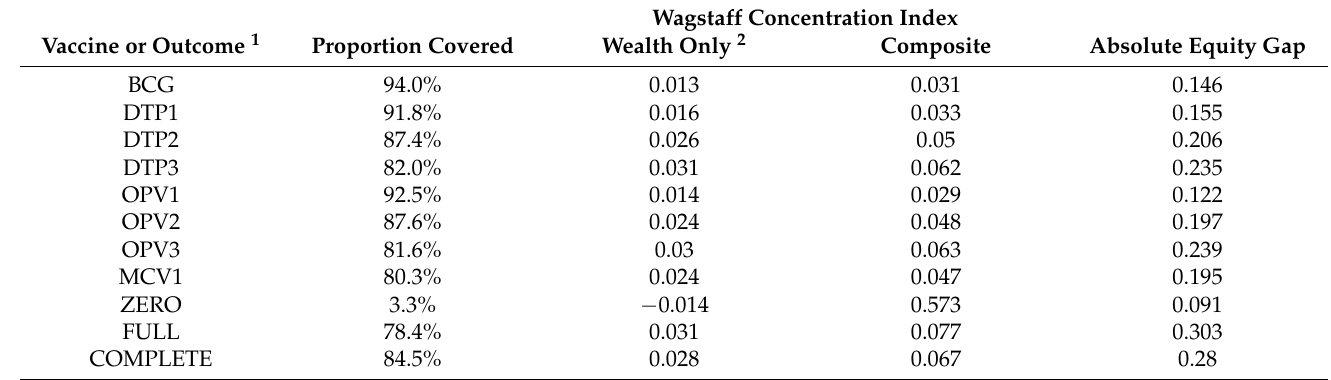
Table 1. National-level metrics for coverage/prevalence, Wagstaff CIs using wealth-only and com- posite ranking metrics, and composite-based AEGs for all Cambodia national immunization program vaccines and comprehensive vaccination statuses for survey year 2014.